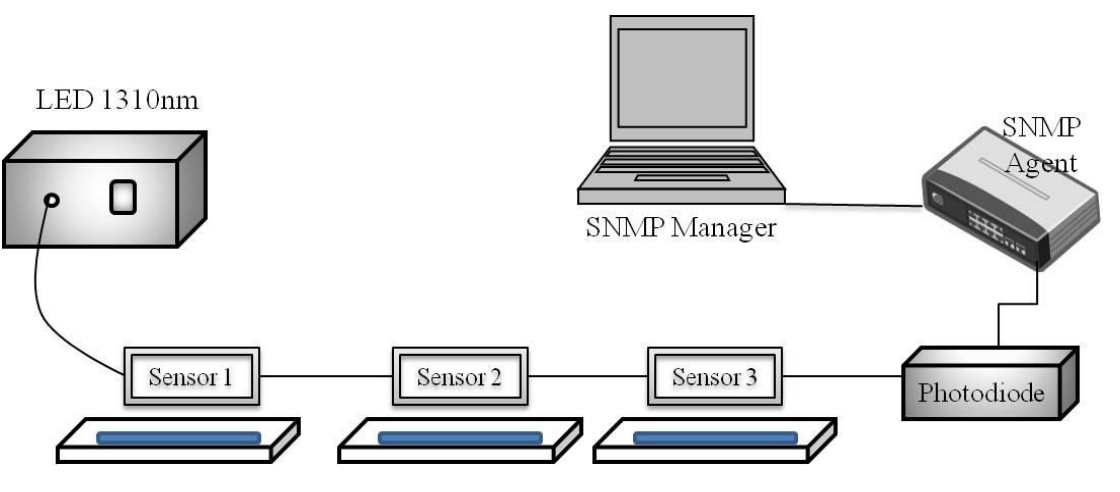
Figure 3. System configuration of sensing system remote management using the SNMP for HC-SPR sensors.